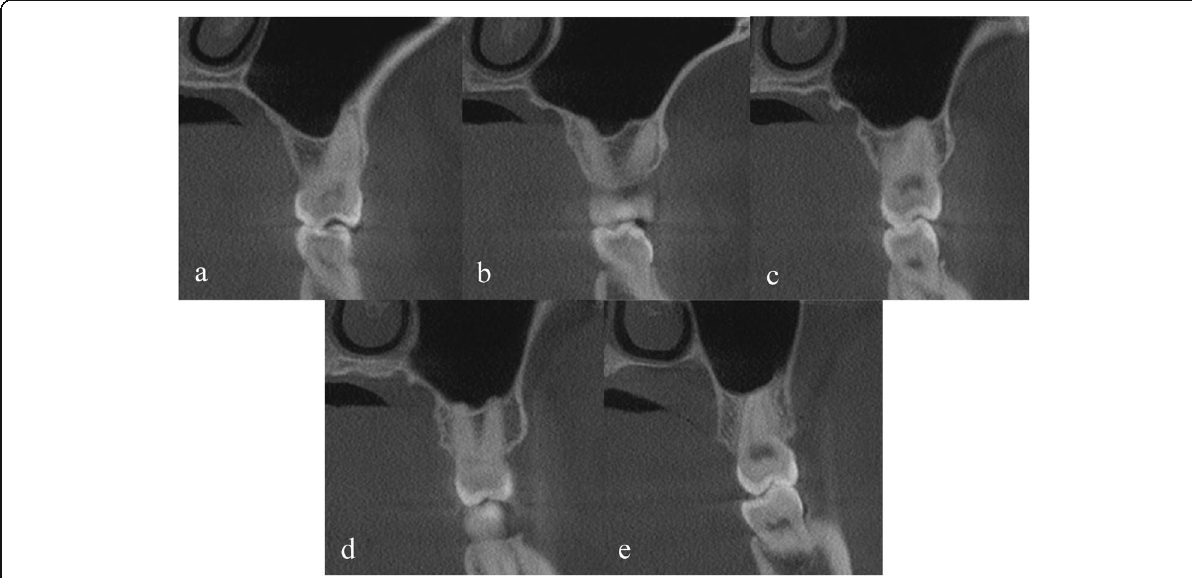
Fig. 3 Cropped coronal cuts for a the mesiobuccal root of the left first maxillary molar, b distobuccal and palatal roots of the left first maxillary molar, c the mesiobuccal root of the left second maxillary molar, d distobuccal and palatal roots of the left second maxillary molar, and e the fused roots of the left third maxillary